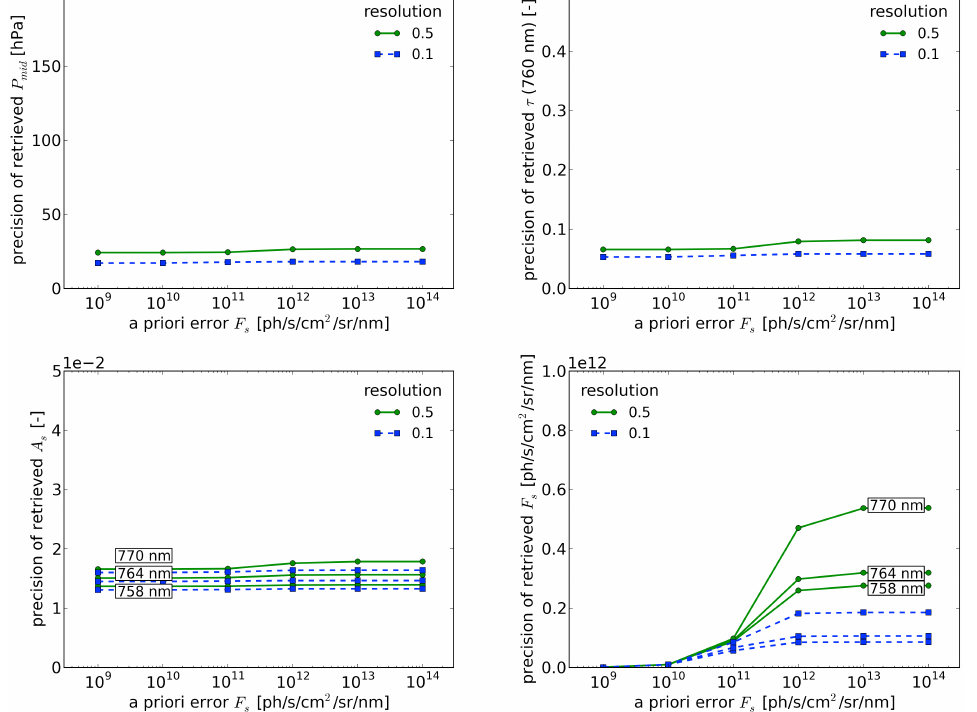
Fig. 5. Precision of the main fit parameters as a function of the a priori error in the fluorescence emission for two spectral resolutions and for retrieval of the full state vector. Top left: mid pressure ( P mid ) ; top right: aerosol optical thickness ( τ) ; bottom left: surface albedo ( A s ) at three wavelength nodes; bottom right: fluorescence emission ( F s ) at three wavelength nodes. Results correspond to the same atmospheric scenario and observation geometry as in Fig. 4. The reference signal-to-noise ratio is 500. Note that precision values for F s are scaled by a factor of 1 × 10 12 .